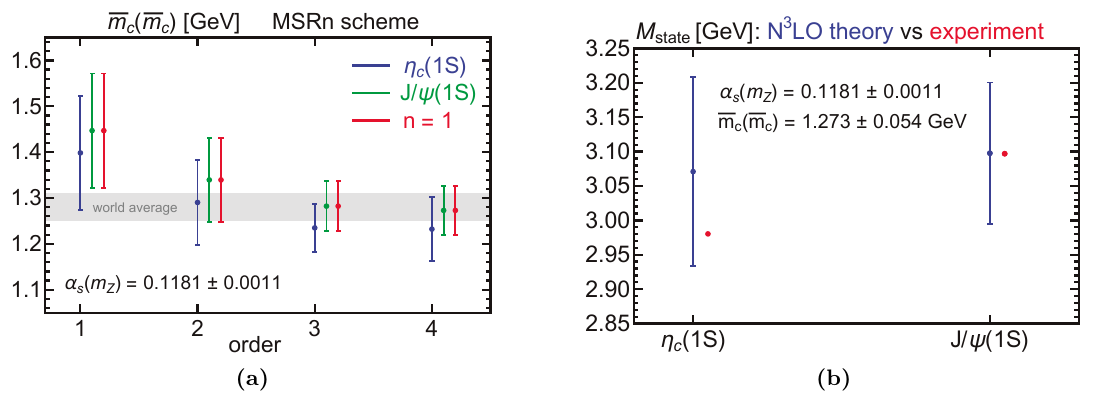
Figure 11. Left panel: charm quark mass determination from the (cid:17) c (blue), J= (green) and both states together (red) as a function of the perturbative order N n LO. The PDG world average value is shown with a gray band. Right panel: prediction of the charmonium masses at N 3 LO (in blue) vs the corresponding experimental values (in red). Experimental error bars are too small to be visible. Both panels: predictions in the MSRn scheme where the error bars correspond to the perturbative uncertainties